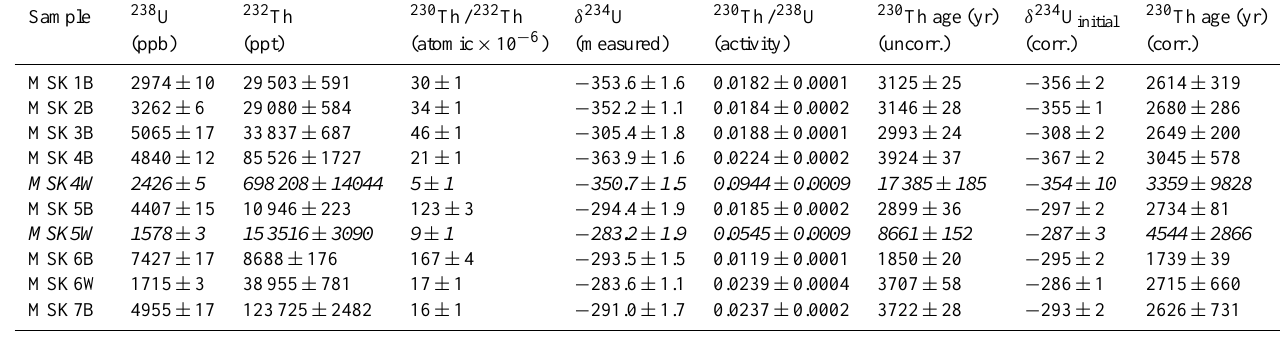
Table 1. 230 Th dating results of cryogenic calcite samples from MSK Cave. Sample numbers refer to those in Fig. 1 (lower panel), and the letter indicates the petrographic type: B – brown crystals; W – white crystals. Two samples were excluded (italics) because of their